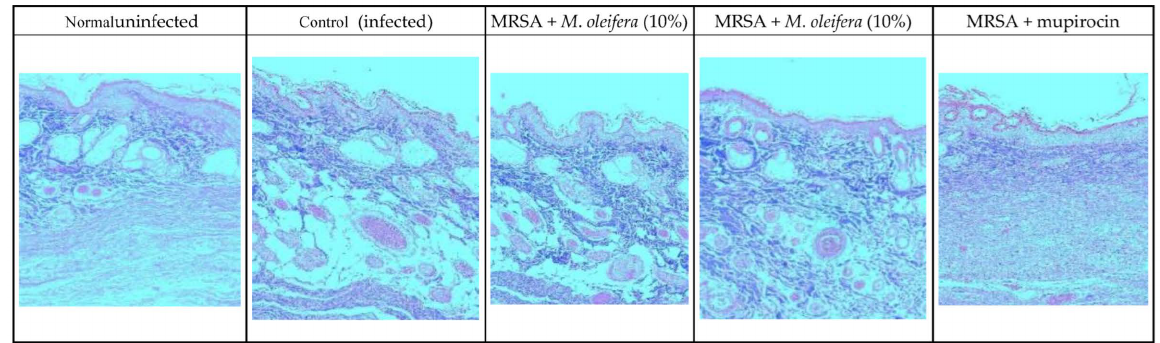
Figure 8. Skin histology of MRSA-infected wound (stained with Masson’s trichrome stain) after different treatments. The blue color indicates collagen.